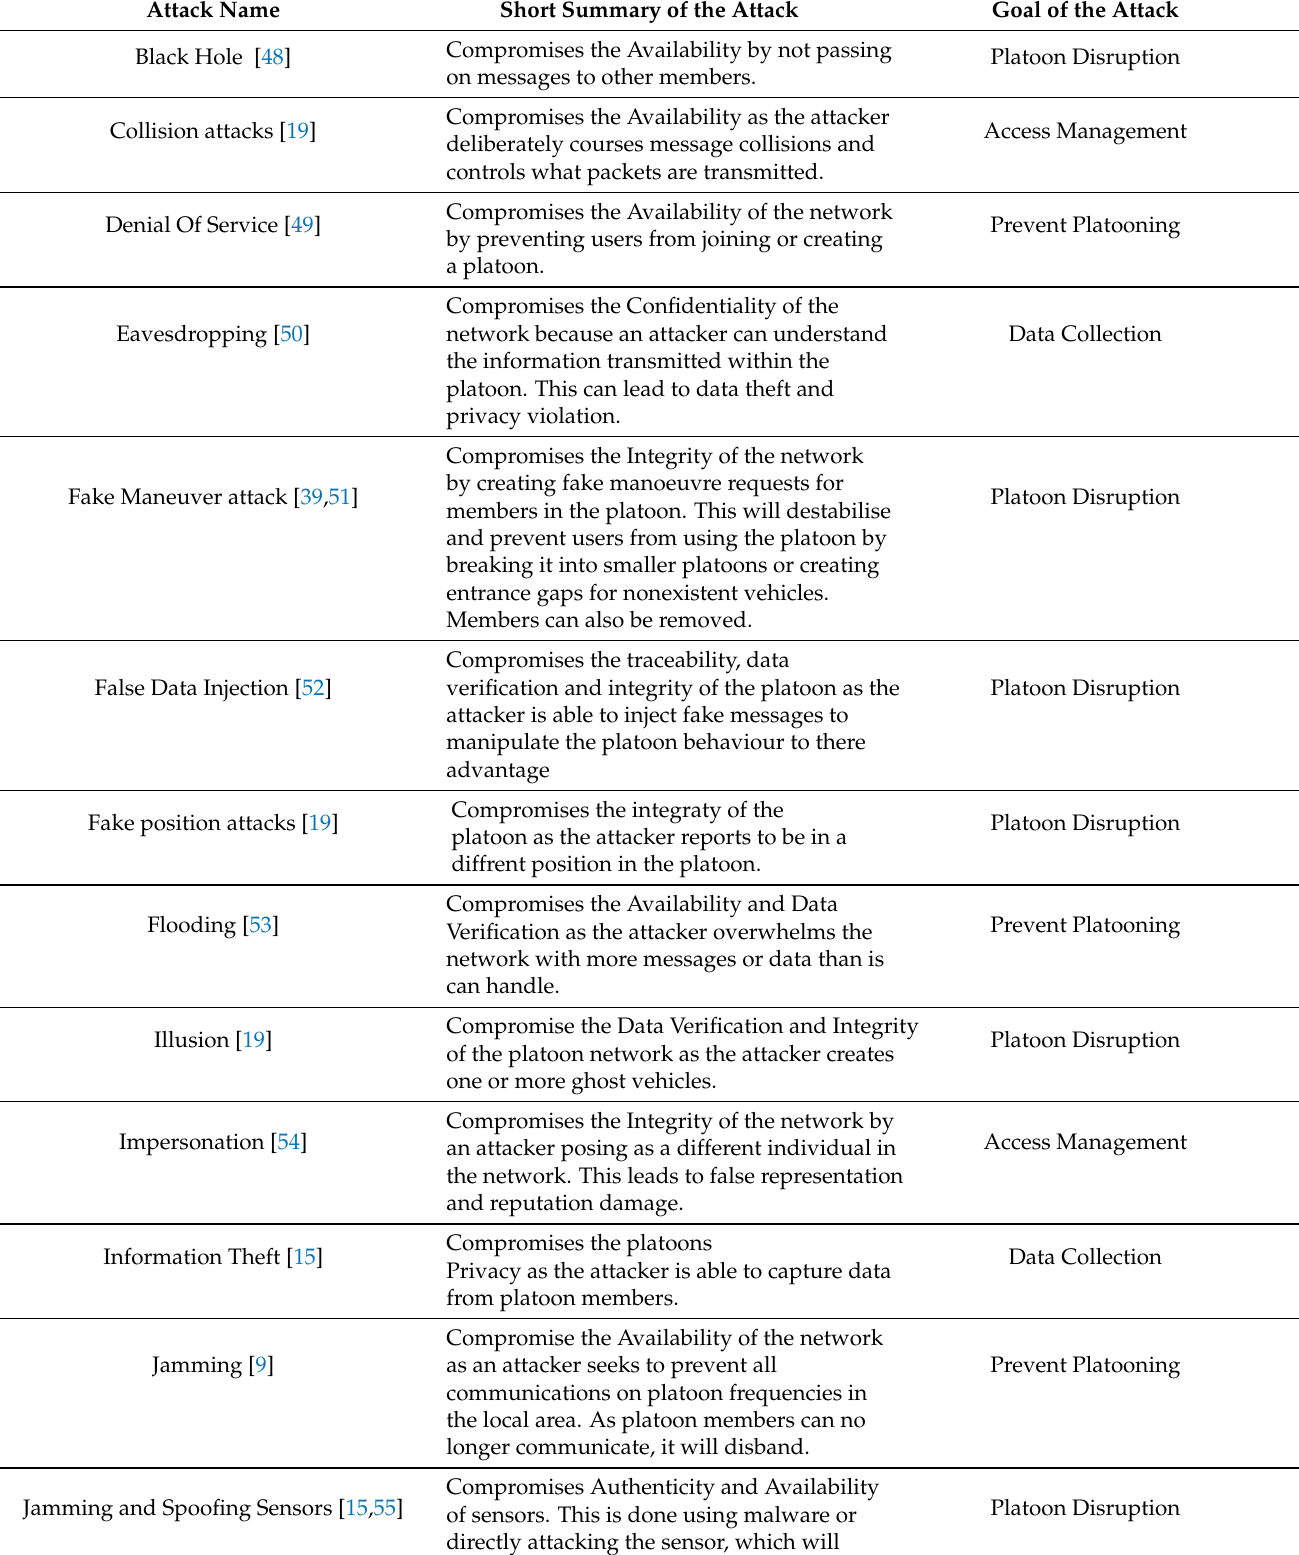
Table 2. Threats to platoons and a summary of how the attack will compromise the